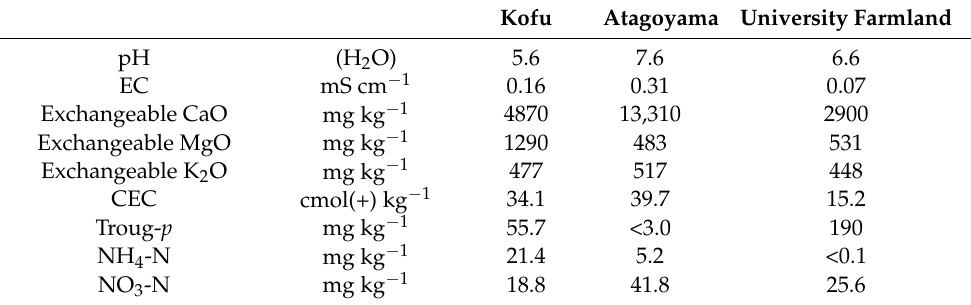
Table 1. Soil chemical